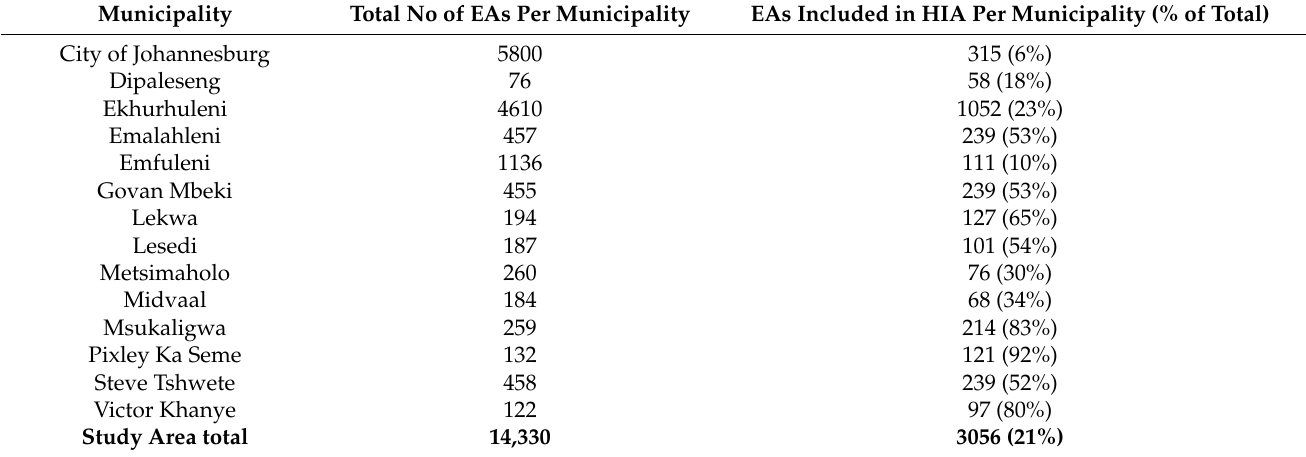
Table 4. Total number of Enumeration Areas (EAs) per municipality and number of EAs included in the Health Impact Assessment (HIA) per